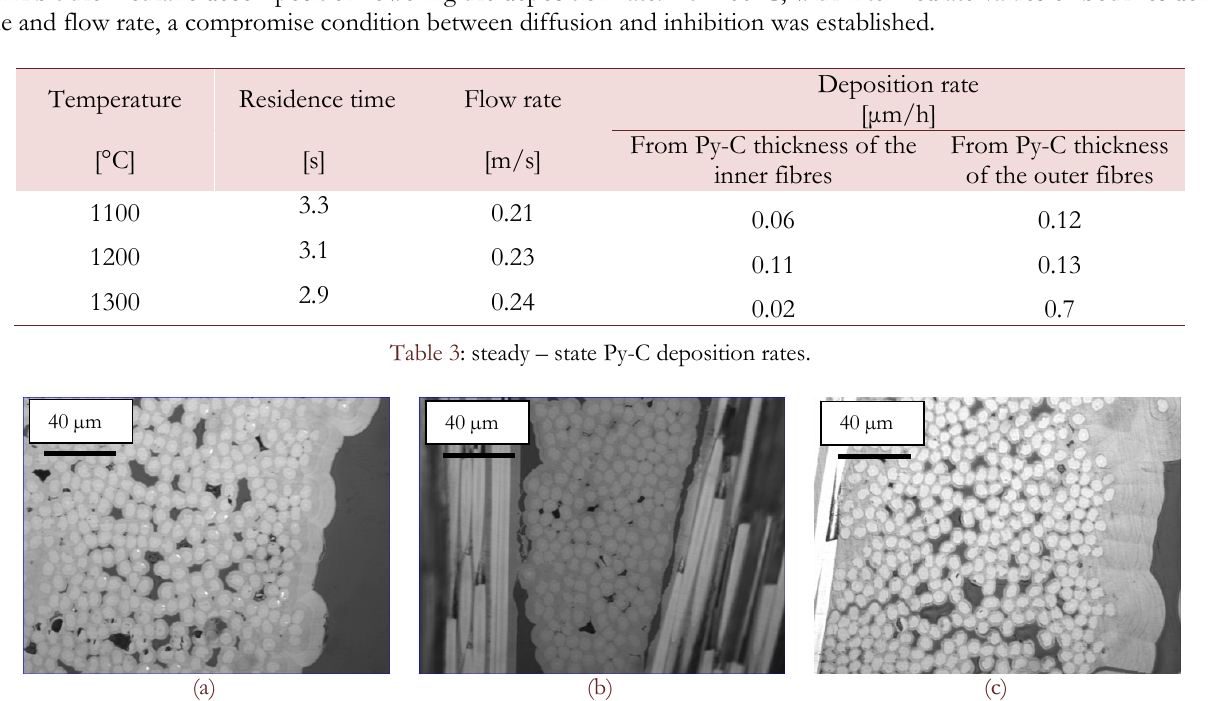
Figure 8: Optical micrographs the C f /C cross sections at (a) 1100 °C, (b) 1200 °C and (c) 1300